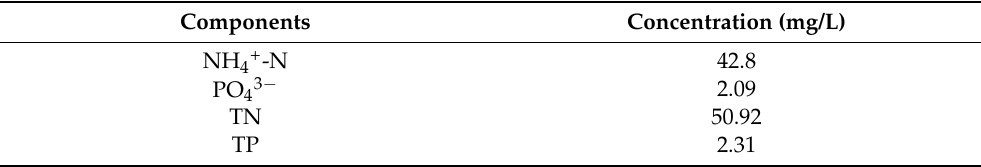
Table A2. The components of 10% (v/v) AW.